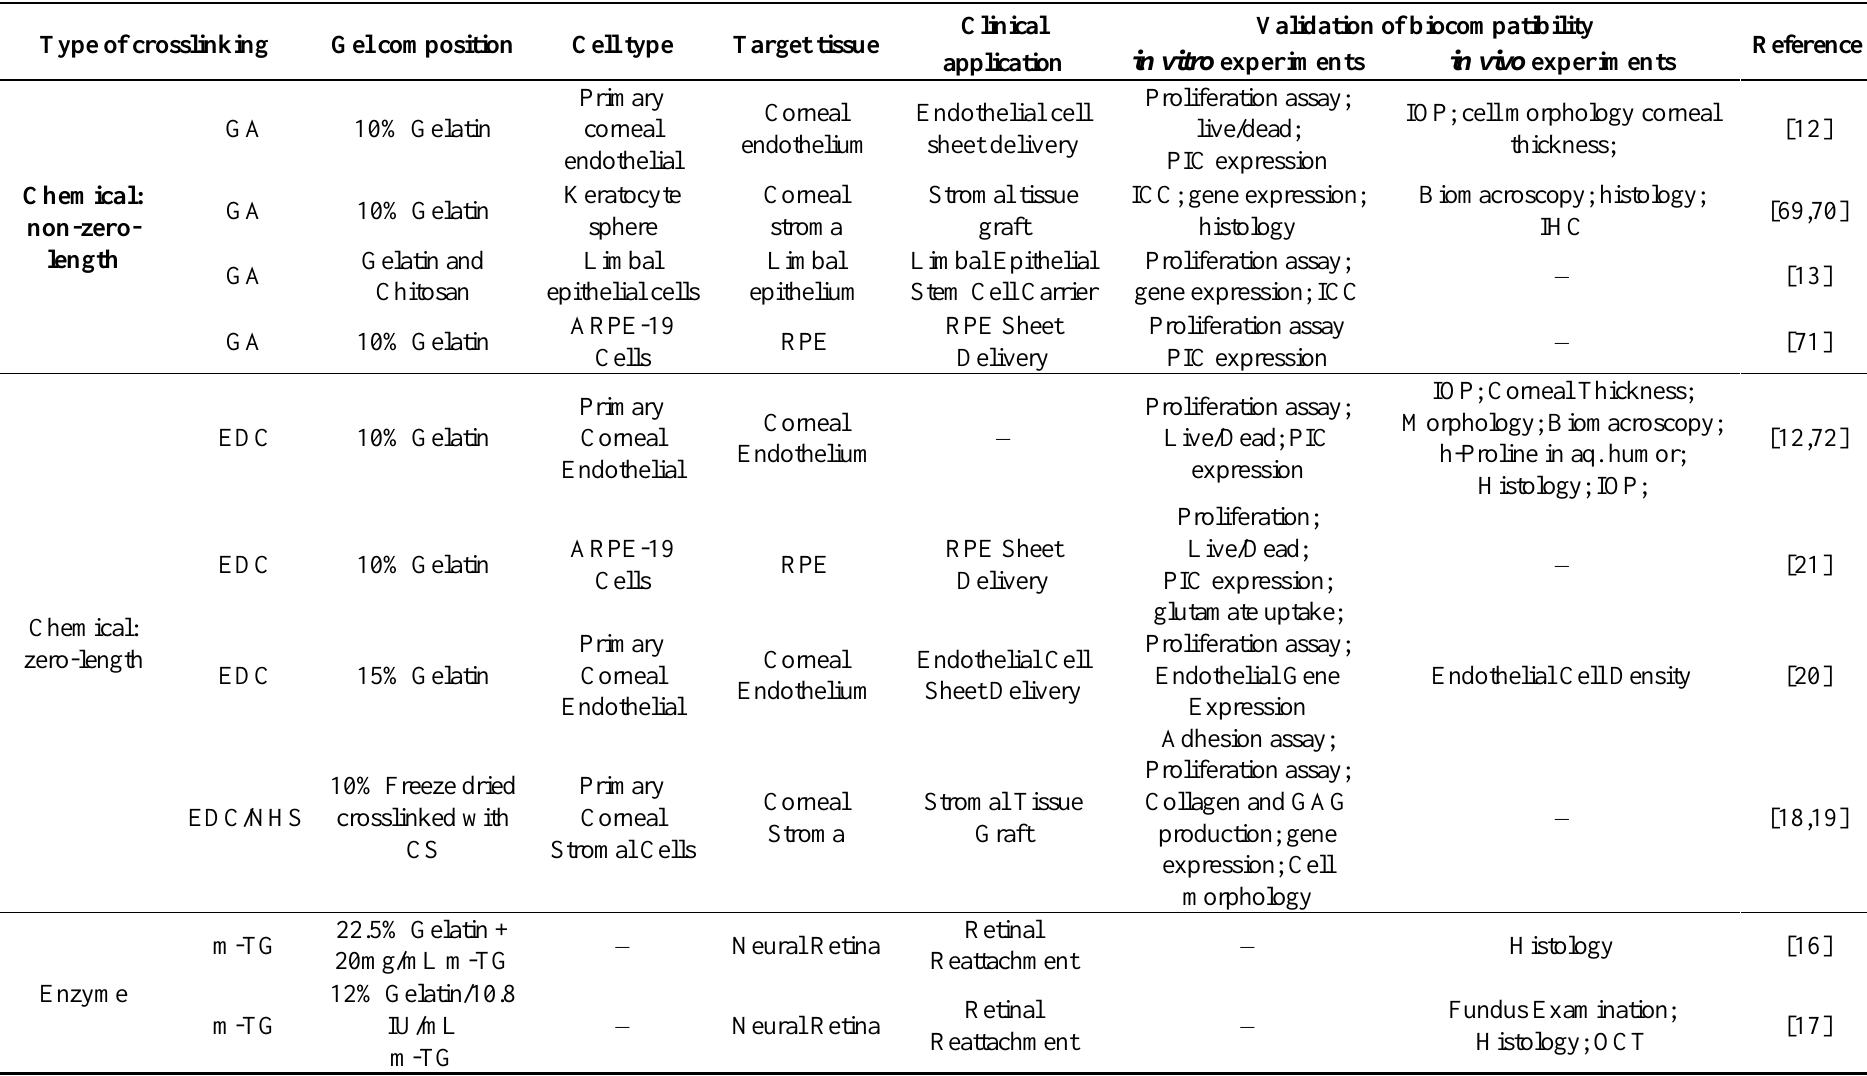
Table 1. Application of crosslinked gelatin in ocular tissue